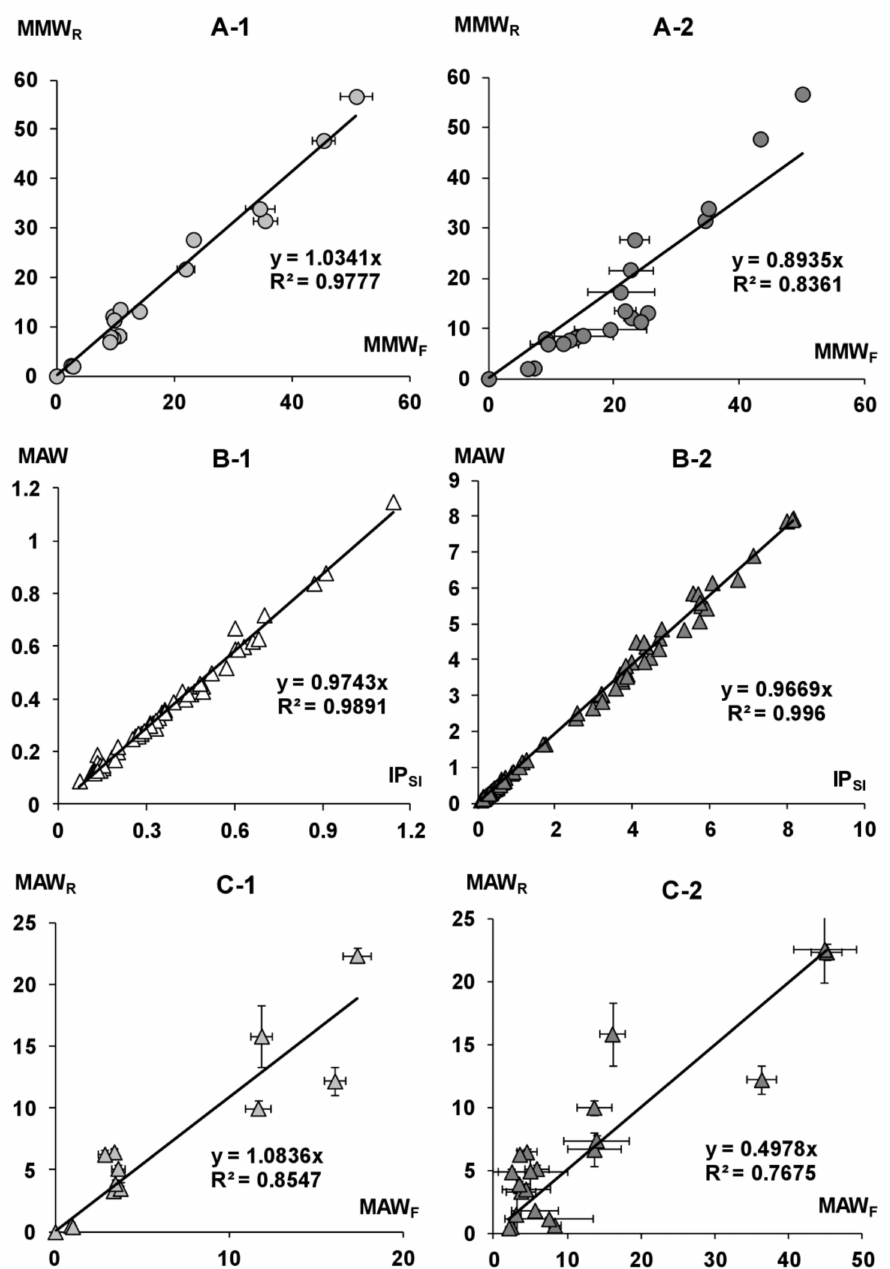
Figure 7. A : Correlation of Voronin’s predicted and real MMW values: ( A - 1 )-fundamental model of disjoining pressure (8), ( A - 2 ) the van Genuchten model. B : Correlation of Voronin’s predicted MAW value and water vapor sorption isotherms inflection points (IP SI ): ( B - 1 ) coarse-textured soils (58 samples), ( B - 2 ) all soil texture classes (105 samples). ( C ): Correlation of Voronin’s predicted and real MAW values: ( C - 1 ) disjoining pressure model, ( C - 2 ) the van Genuchten